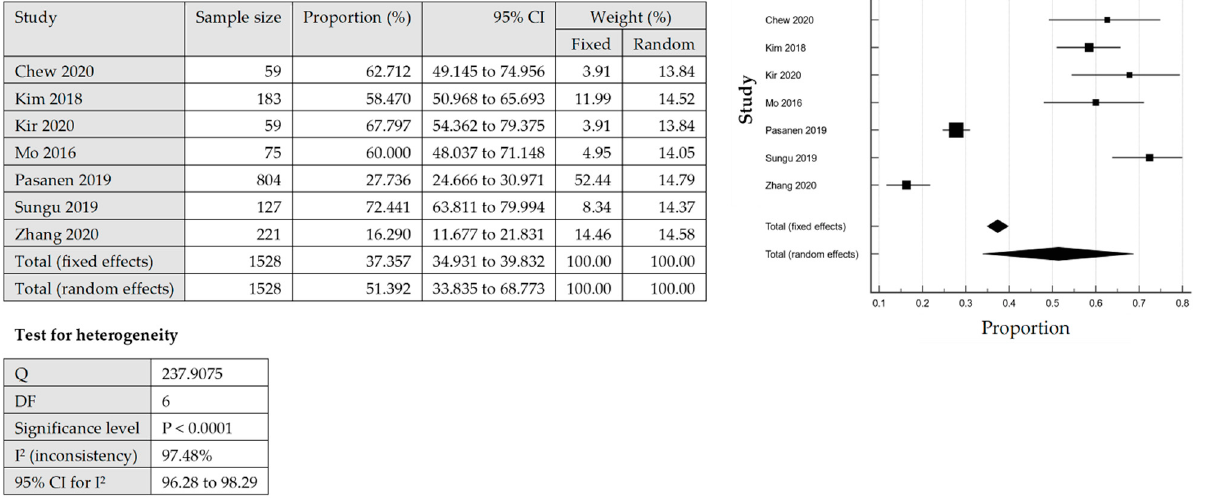
Figure 3. The pooled prevalence of PD-LI positive expression in immune cells (ICs) among the en- dometrial cancer cases